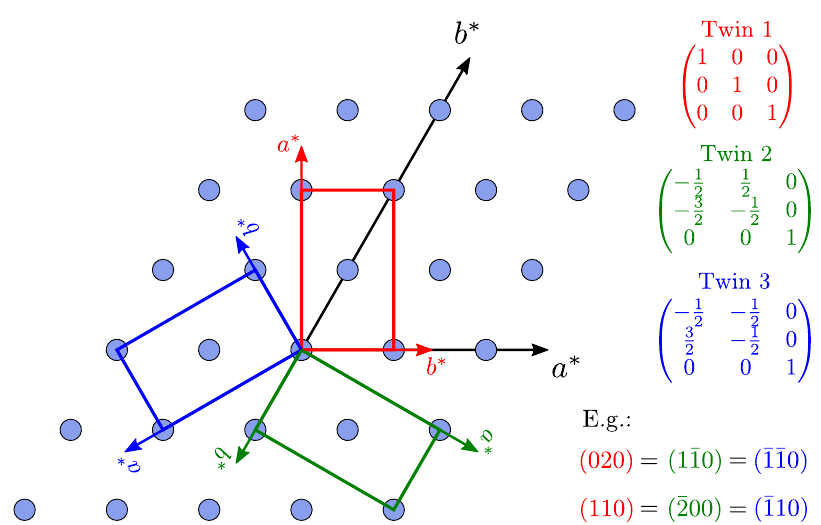
Figure 2: Sketch of the reciprocal space showing 3 twins rotated by 120 ◦ as a con- sequence from a high-temperature structural transition from a trigonal to an or- thorhombic structure. The actually observed scattering vectors Q are obtained by multiplying the twin matrices by the nominal Q vector of twin